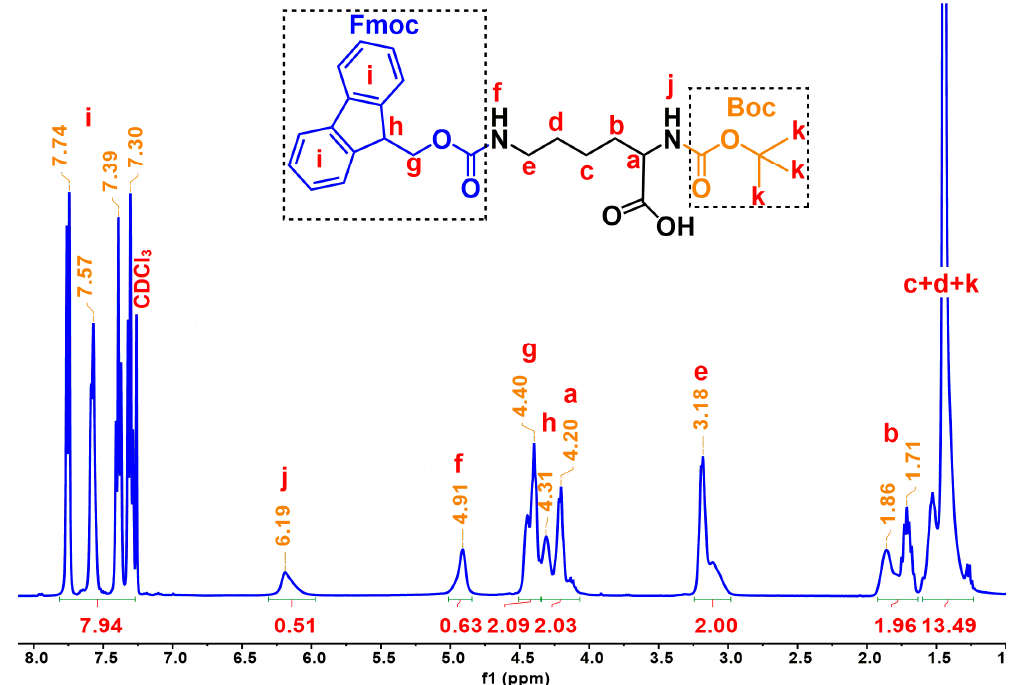
Figure 2. 1 H-NMR spectrum of N ε -Fmoc- N α -Boc- L -Lysine in CDCl 3 .